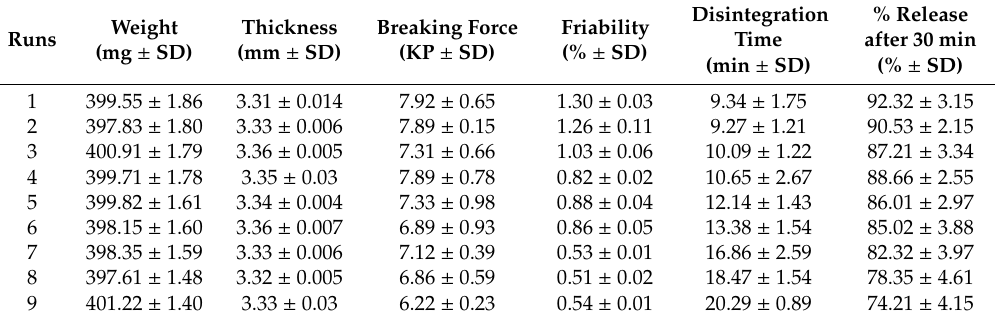
Table 4. Physical properties of prepared canagliflozin tablets (mean ± SD).